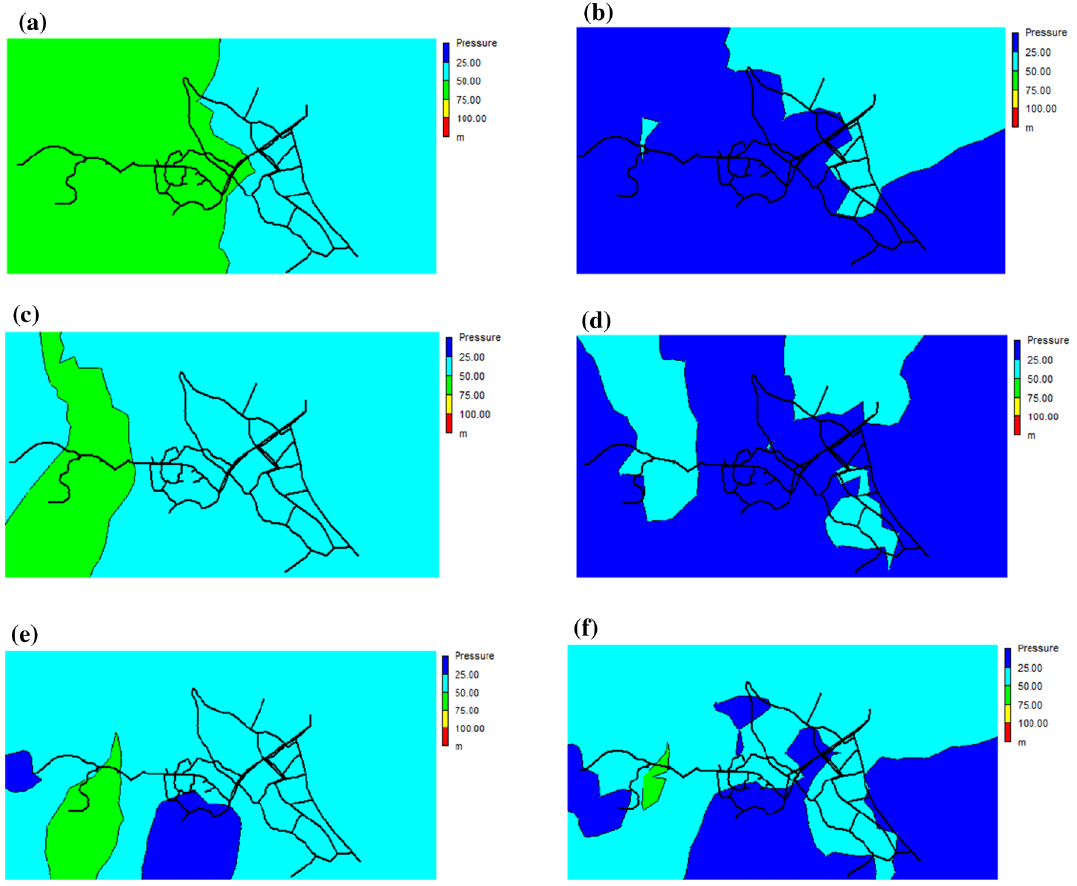
Fig. 14 Distribution of pressures with 6 PRVs (right) and without PRVs (left) with various demand pattern factors. Demand pattern of 0.36 a without PRVs b with 6 PRVs; Demand factor of 0.86 c without PRVs d with 6 PRVs; Demand factor of 1.34 e without PRVs f with 6 PRVs Table 7 Comparisons of water = leakage flows with 𝛾